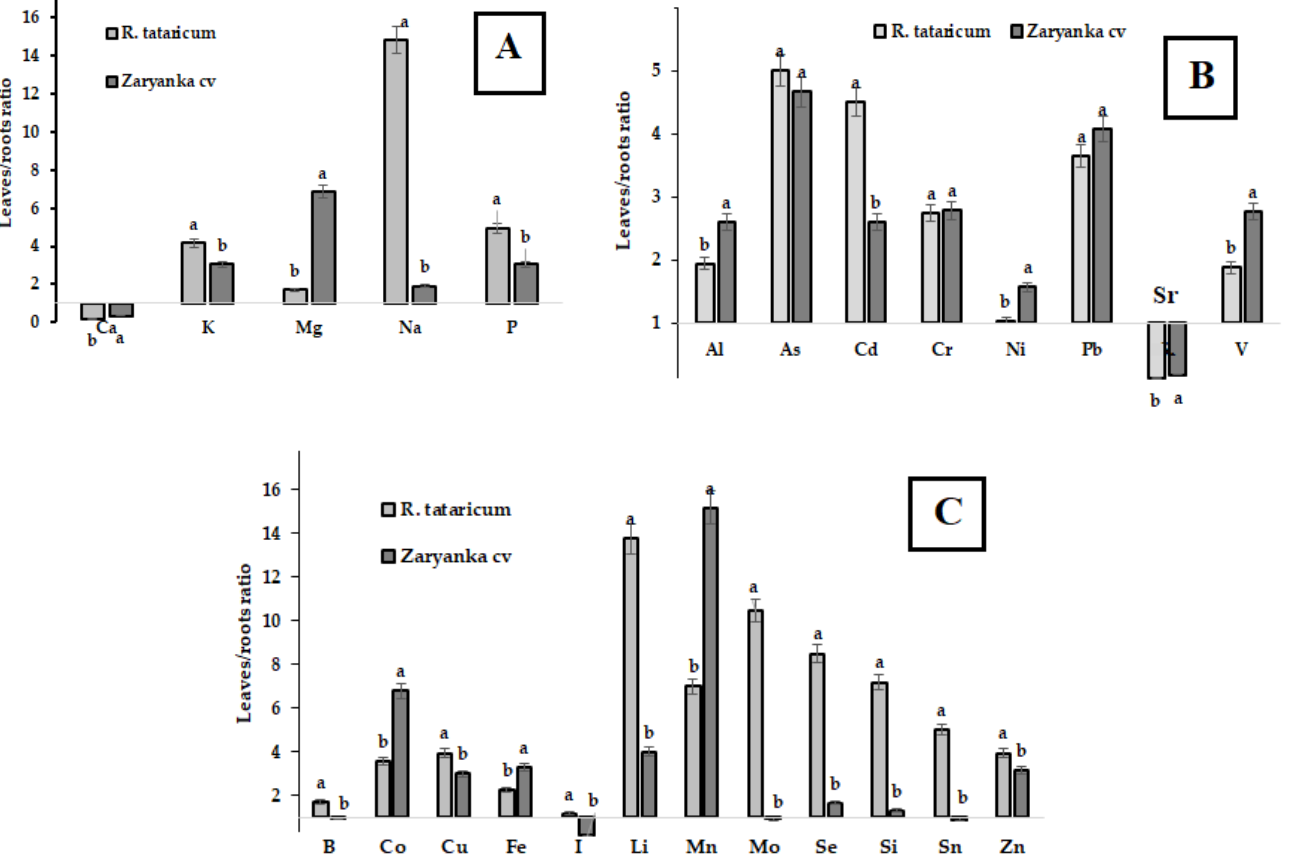
Figure 6. Leaves/roots distribution of macro elements ( A ), Al, As and heavy metals ( B ) and microelements ( C ) in R. tataricum and rhubarb cv. Zaryanka. For each element values with similar letters do not differ statistically according to Duncan’s test at p < 0.05.